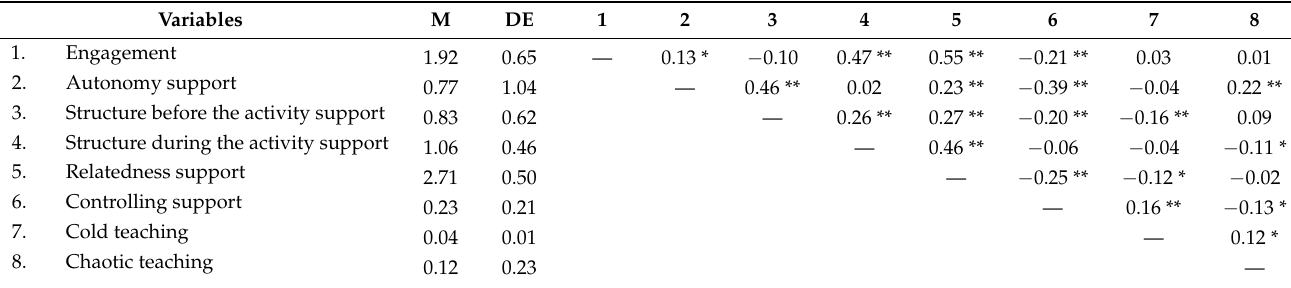
Table 2. Descriptive statistics and correlations between the analysed teacher and student variables. Variables